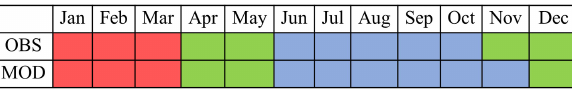
Figure 13. Monthly attribution of each ocean carbon regime in observations and the GISS climate model. Temporal attribution is based on the distance of each monthly 2-D histogram to the cen- troid of each cluster. Referring to austral seasons, blue denotes the cold month regime (winter regime), red the warm months (summer regime) and green the transition regime, since this is more a mix of the other